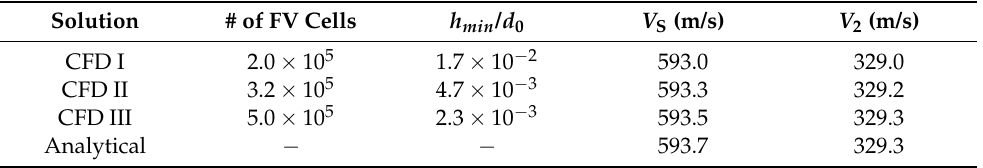
Table 4. Shock tube flow: traveling velocities for different CFD solutions.